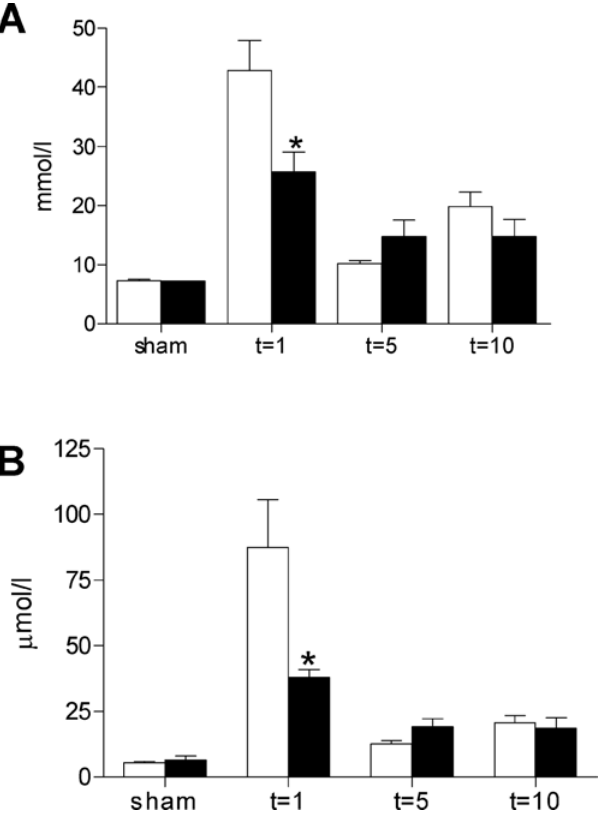
Figure 1. Renal function parameters of wild type and TLR4 2 / 2 mice. Renal function of TLR4 2 / 2 mice (black bars) was improved compared with that of the wild type mice (white bars) one day after renal I/R as reflected by lower serum urea (A) and creatinine (B) levels. Data are mean 6 SEM of 8 mice per group (sham-operated animals: n=3/group). * p ,